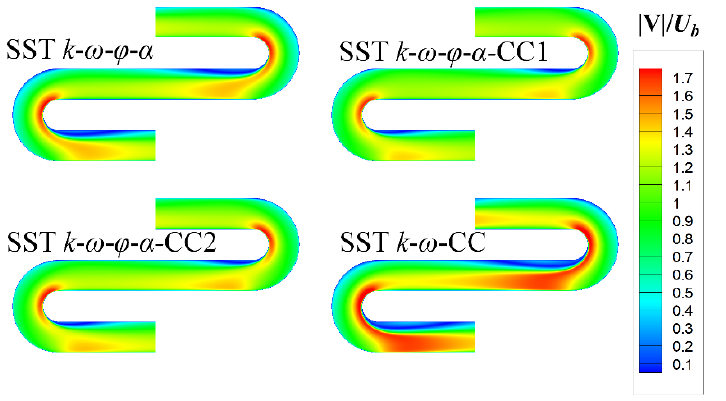
Figure 2. The velocity magnitude contours predicted by different turbulence models for the 2D infinite serpentine passage flow.